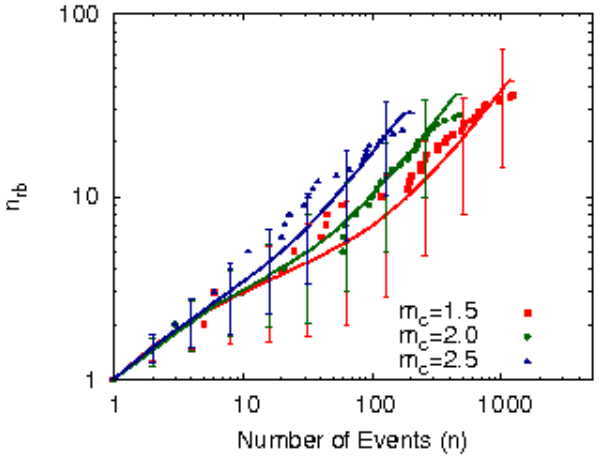
Fig. 5. Lengths of record-breaking longest intervals, 1t rb , are given as a function of event number n (natural time). Results are given for the Parkfield aftershock sequence, starting 0.01days after the main- shock, compared to a simulated non-homogeneous Poisson process (NHPP). The blue, green and red points represent data from the Parkfield aftershock sequence for m c = 1 . 5 , 2 . 0 , 2 . 5, respectively; these data points are shifted 50events to the right to further mitigate seismographic anomalies in the coda. The solid lines and error bars of the same colour represent the mean and standard deviation, over 1000simulations, from the corresponding